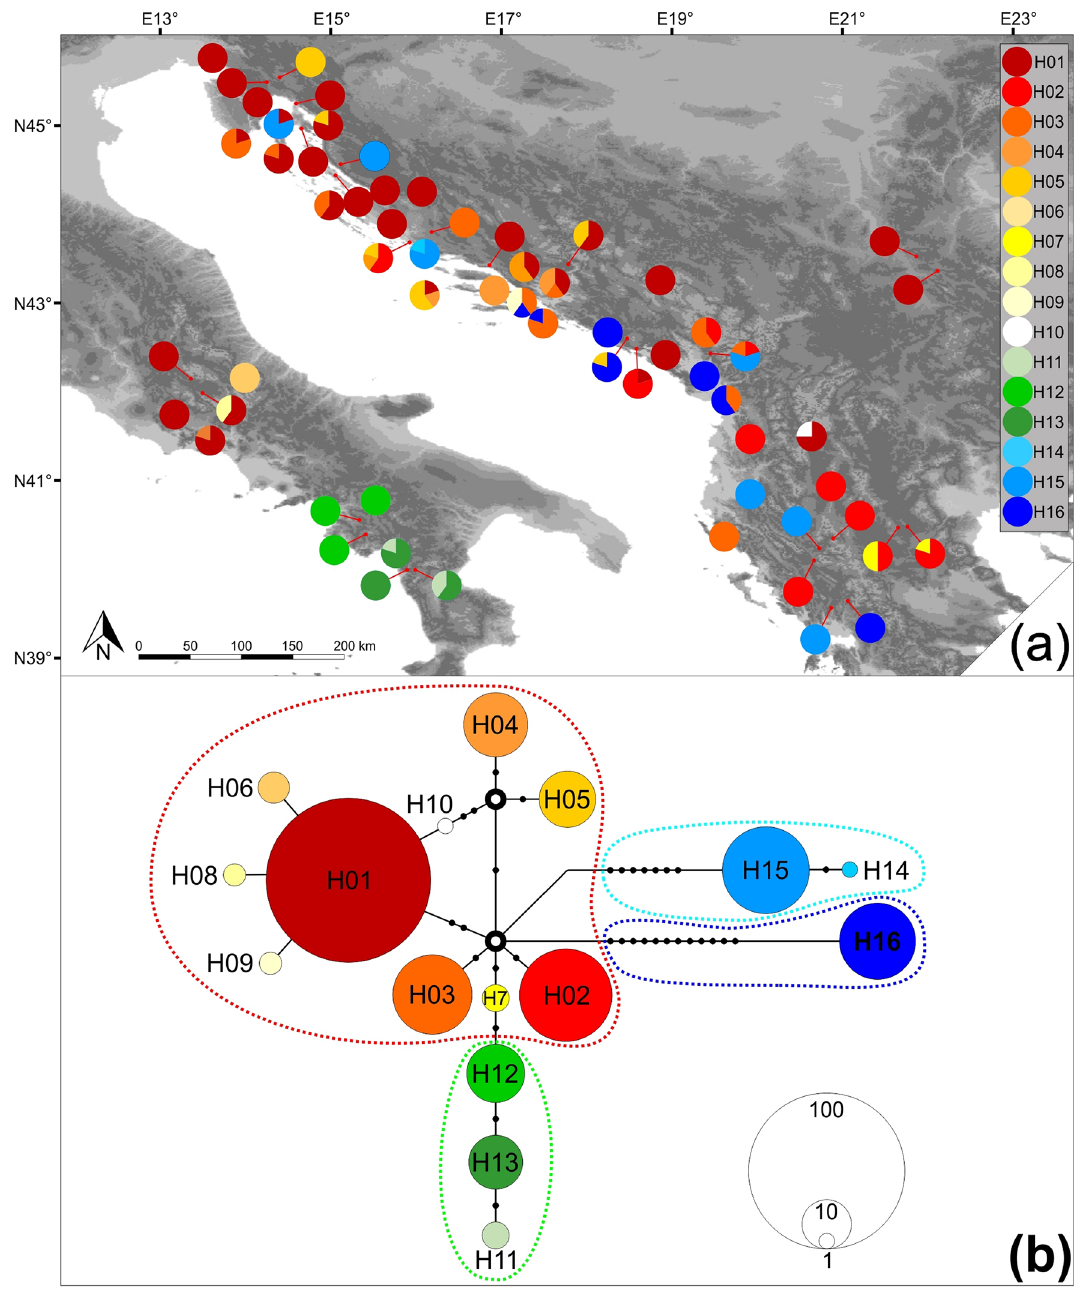
Figure 3. ( a ) Geographic distribution of 16 cpDNA haplotypes throughout common sage ( Salvia officinalis L.) distribution range. The proportion of colours in each pie corresponds to detected haplotype frequencies in the population. The haplotype colour code is on the right. The satellite imagery was obtained from Natural Earth public domain map dataset (https:// www. natur alear thdata. com/ downl oads/ 10m- raster- data/ 10m- gray- earth/). CorelDraw Graphics Suite X7 Version 17.1.0.572 (Corel Corp., Ottawa, Canada) was used to create the figure. ( b ) Median-joining haplotype network. Each filled circle indicates a unique haplotype, and black dots represent mutational steps (i.e., missing haplotypes). Two ancestral haplotypes are presented as empty bold circles in the middle of the network. The diameter of circles is proportional to the observed overall frequency of the haplotype, with a corresponding scale in the lower right corner. Dashed lines indicate four haplotype groups: the red line the largest group distributed throughout the Balkans and the Central Apennines, the green line one from the Southern Apennines, and light blue and dark blue lines indicate two highly differentiated lineages from the